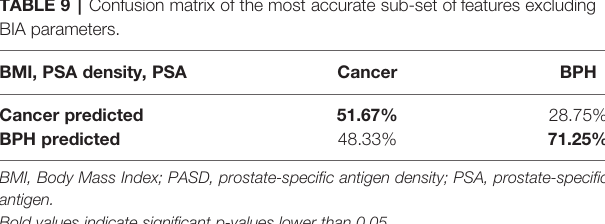
Bold values indicate signi fi cant p-values lower than